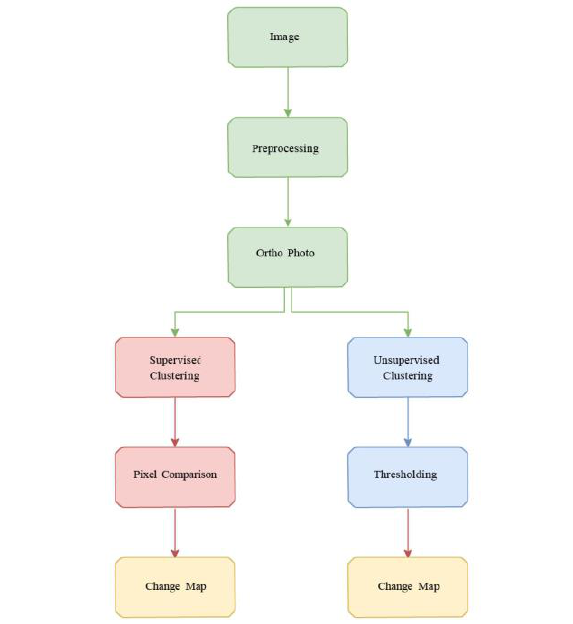
Figure 3. Workflow diagram for change detection